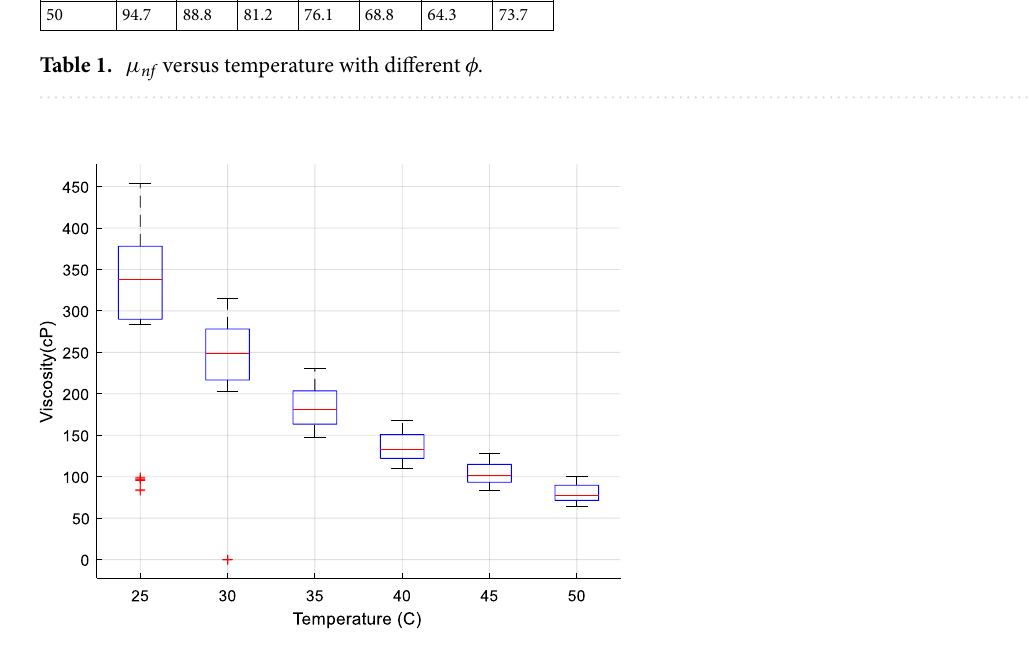
Figure 2. µ nf deviation based on temperature